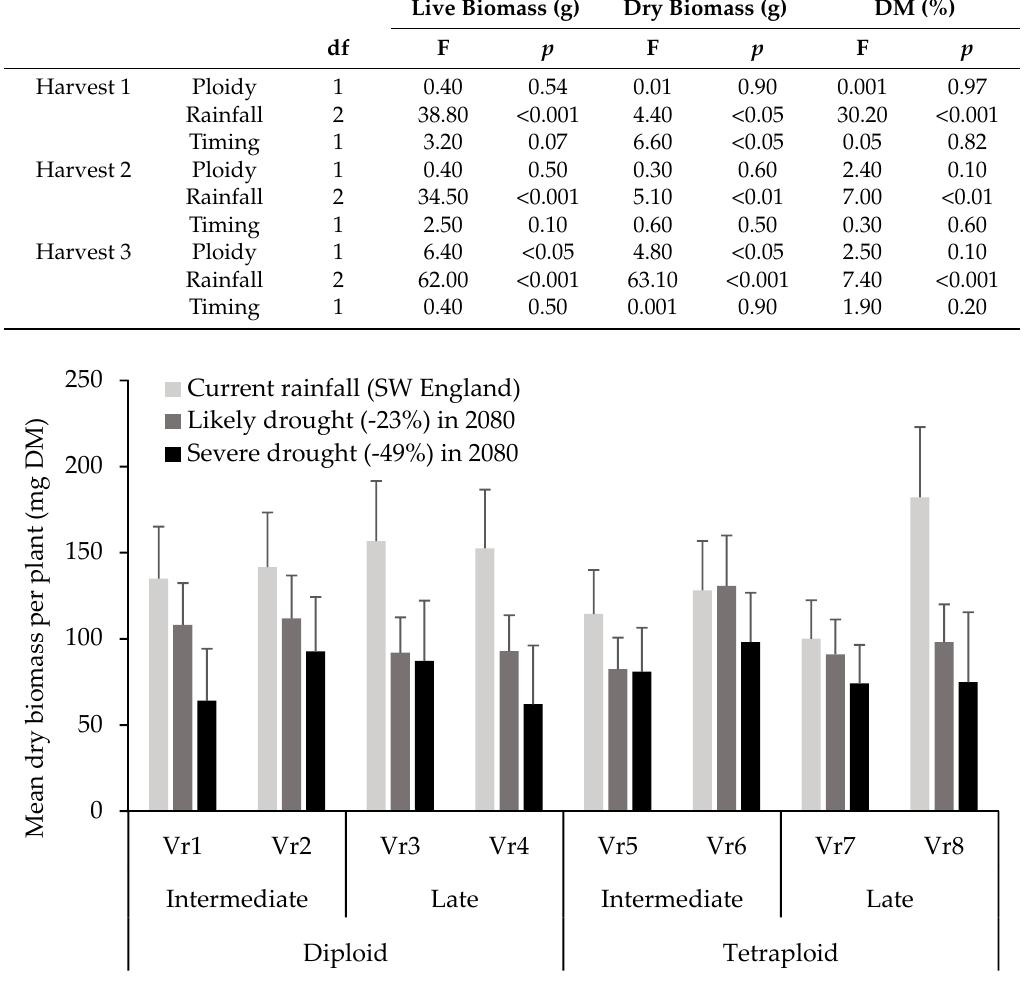
Figure 1. Mean dry biomass (with standard error bars) produced by each variety (Vr) averaged across all three harvests. Varieties are partitioned by ploidy (diploid or tetraploid) and by flowering time (intermediate or late).